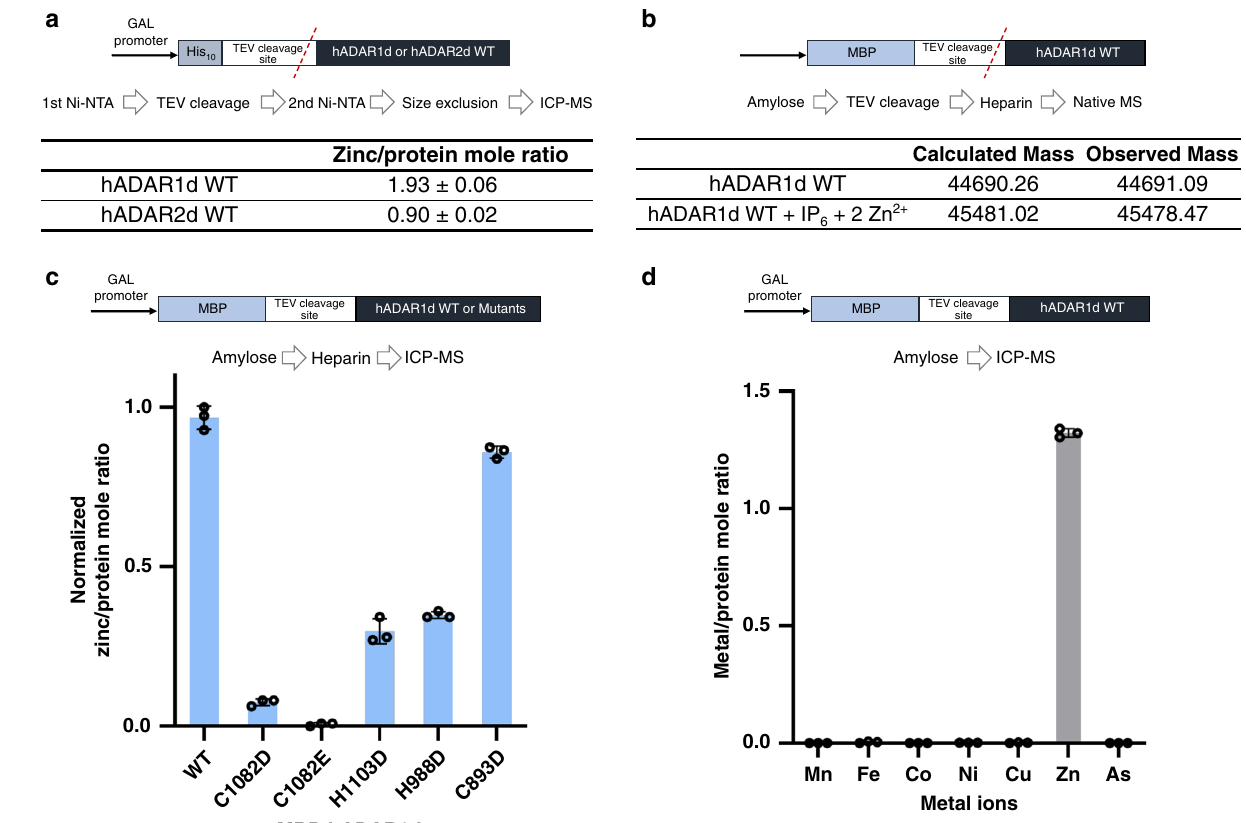
Fig. 5 Metal analysis results of hADAR1d by ICP-MS and protein native MS analysis. Protein construct design and puri fi cation steps are shown for each experiment. a Zinc/protein mole ratio of His 10 -tag fusion of hADAR1d WT and hADAR2d WT as control represented in mean±s.d. from three independent experiments. b Results of protein native MS. Observed mass and calculated mass of intact LC-MS (top row) and native LC-MS (bottom row) analysis are shown in the table. The observed mass is consistent with the calculated values within the errors of measurement and ambiguity in the protonation state of IP 6 that is bound to the protein. c Zinc/protein mole ratio of MBP fusion hADAR1d WT and mutants (C1082D, C1082E, H1103D, H988D, and C893D). d Metal/Protein mole ratio from metal screening ICP-MS result of MBP-hADAR1d WT that was puri fi ed without metal supplementation. Data in ( c ), and ( d ) are plotted as the mean±s.d. from three independent experiments. Individual data points are shown with black